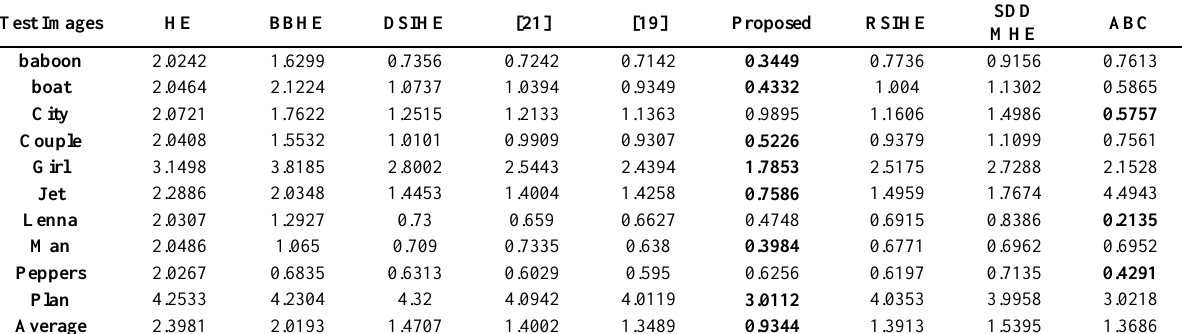
Table 3. Comparing various methods with